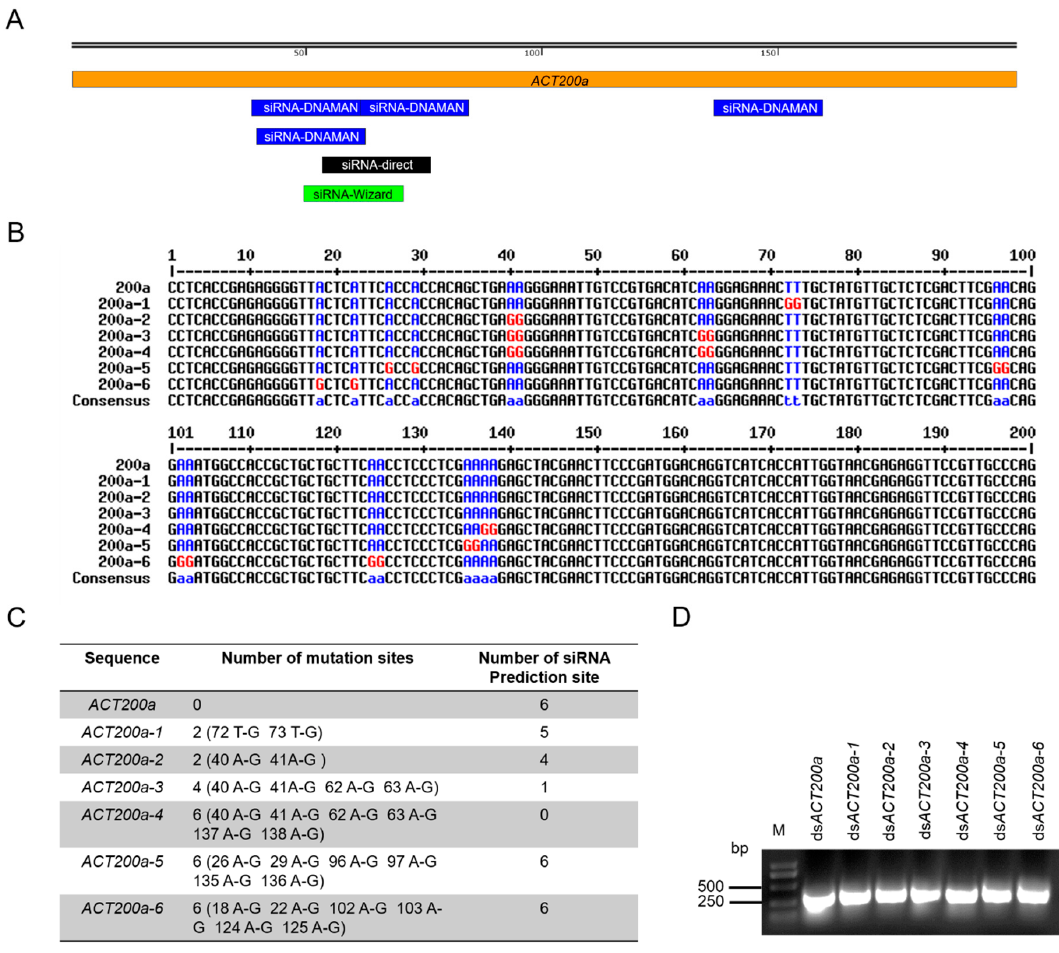
Figure 1. Introduction and in vitro synthesis of ds ACT s with point mutations. ( A ) The relative location of effective siRNA candidates at ACT200a which were predicted by indicated bioinformatic toolboxes (DNAMAN, siDirect and siRNA Wizard). ( B ) Alignment of original ACT200a sequence with mutated ACT200a variants. The high consensus base pairs are represented as blue. The mutated base pairs are indicated as red. ( C ) Summary of the number and location of mutations in ( B ). ( D ) Analysis of the synthesized ds ACT s by electrophoresis. M, 1 kb DNA ladder.